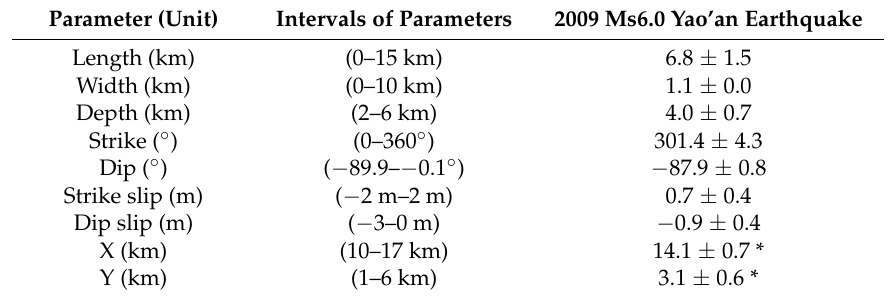
Table 2. Source fault parameters and their 2-standard deviations for the 9 July, 2009 Yao’an earthquake.